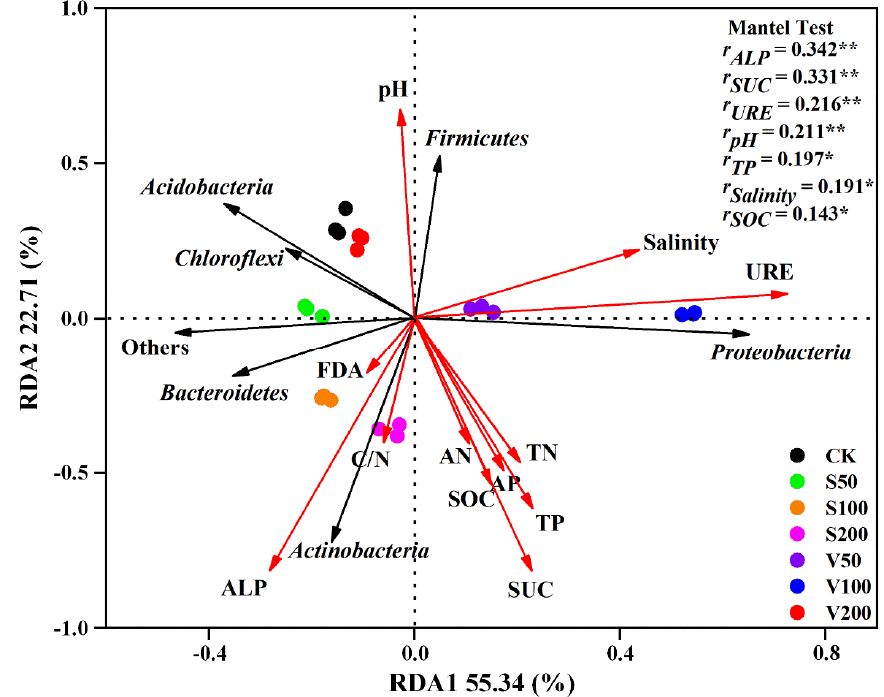
Figure 4. Redundancy analysis (RDA) of soil physicochemical properties and enzyme activities on bacterial community structure. “*” and “**” indicate p < 0.05 and p < 0.01, respectively.